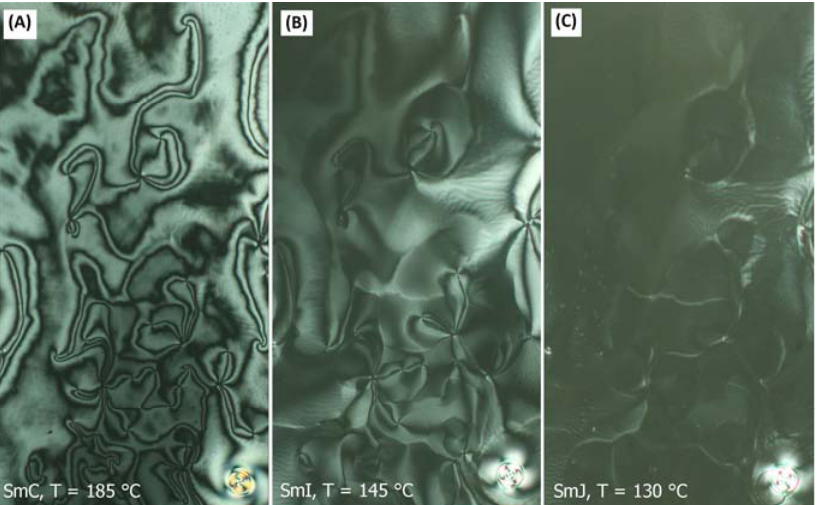
Figure 2. Optical textures observed in liquid crystalline phases of crosslinker ‘C’ for sample with one free surface: ( A ) SmC at 185 °C, ( B ) SmI at 145 °C, and ( C ) SmJ at 130 °C. The width of the pictures is about 100 μ m.